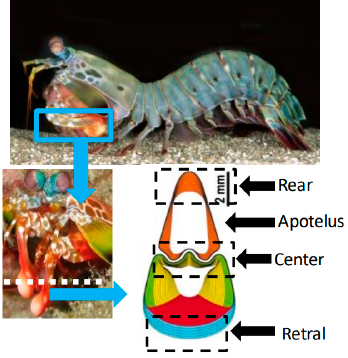
Figure 1. Structure of shrimp chela. [11]